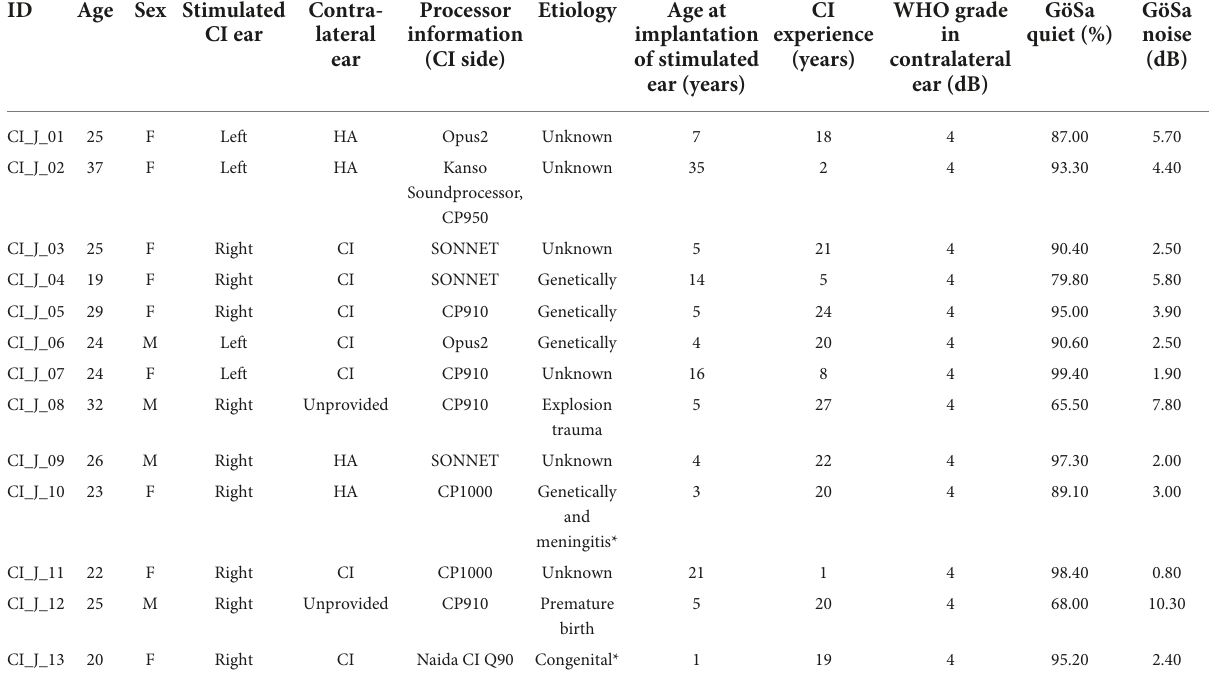
TABLE 1 Demographic variables of the young participants with CI.